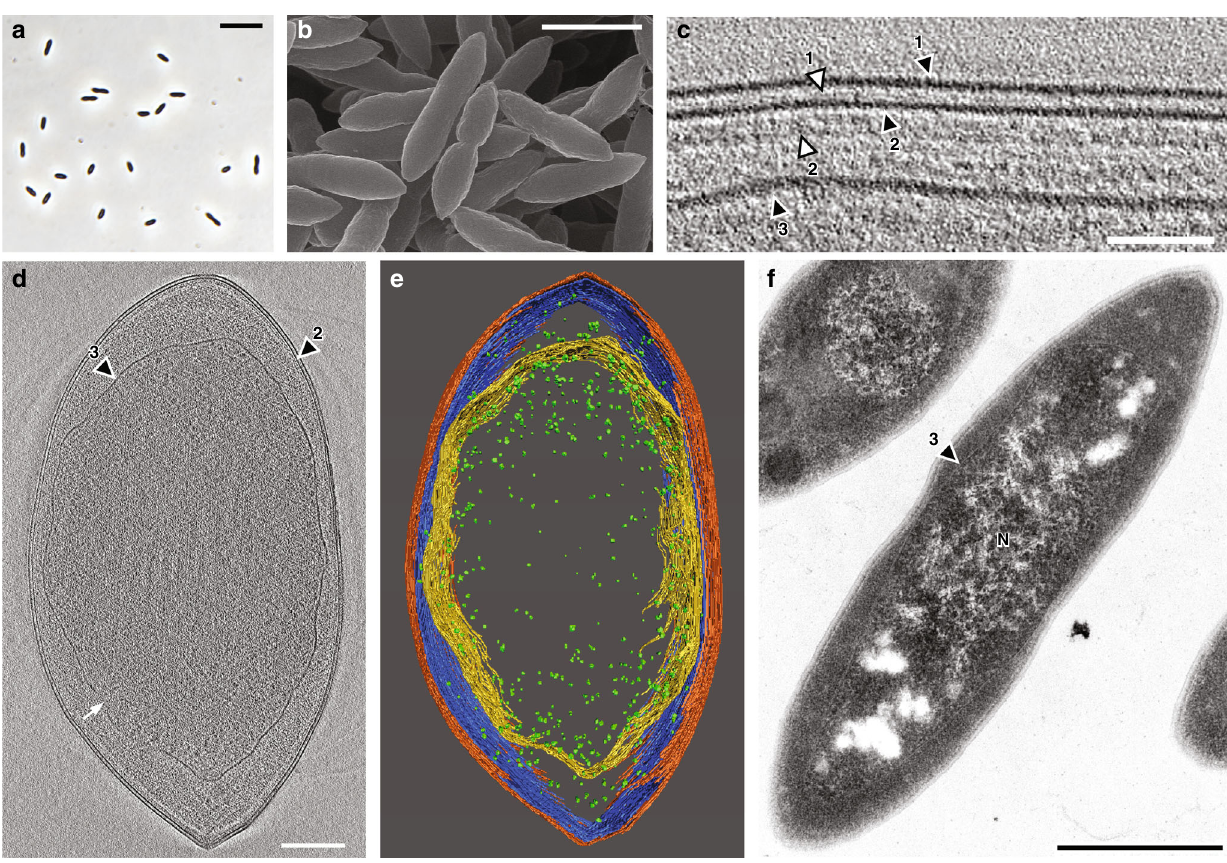
Fig. 1 Morphology and membrane structure in RT761 cells showing the presence of three lipid membrane-like layers (LMLs) with the innermost layer surrounding the nucleoid. a Phase-contrast microscopy. b Scanning electron microscopy. c – e Cryo-electron tomography (also see Supplementary Movies 1 and 2). c The original slice picture is shown in Supplementary Fig. 4. Black arrowheads indicate the outer (1), middle (2), and inner (3) LMLs. White arrowheads indicate the 2.2 nm thick layer (1) and faint layers (2). d White arrow indicates inner LML invagination. e 3D-rendered reconstruction of the cell in d . (also see Supplementary Movie 4). Color code: outer LML, orange; middle LML, blue; inner LML, yellow; ribosome, green. f Transmission electron micrograph of a thin section of RT761 cells. N nucleoid. Scale bars, 5.0 μ m ( a ), 1.5 μ m ( b ), 0.2 μ m ( c ), 0.1 μ m ( d , e ), and 0.5 μ m ( f ).